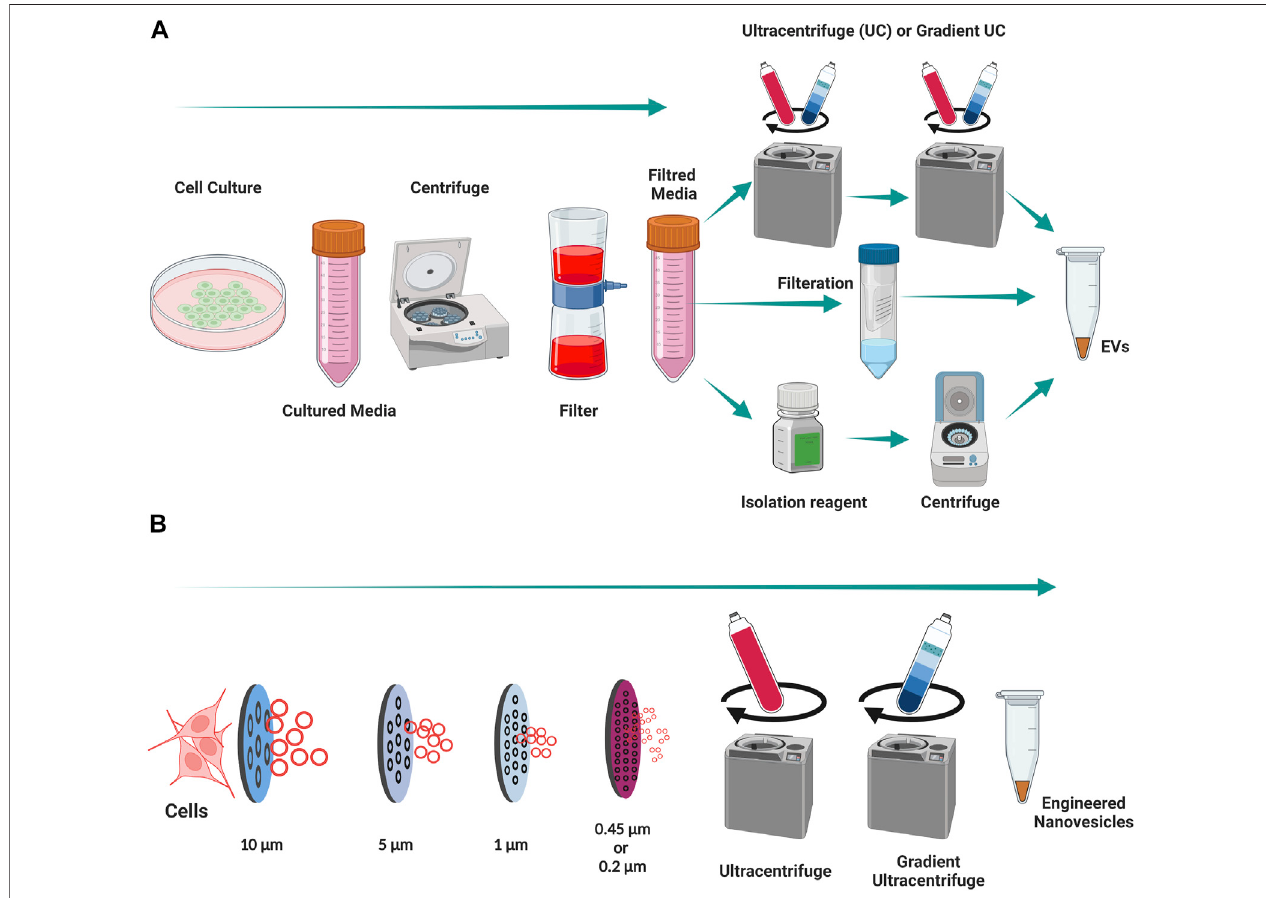
FIGURE 3 | Isolation of EVs and engineering of nanovesicles from Cells. (A) An illustration of isolation of EVs from cell cultured media. (B) An illustration of engineering of nanovesicles from cells. Created with BioRender.com.